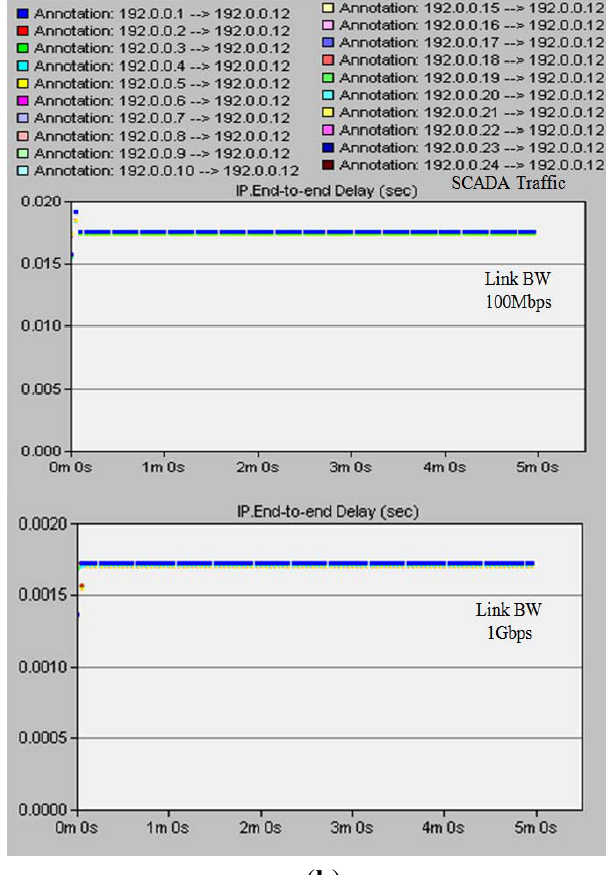
Figure 13. ( a ) ETE delay of SCADA traffic for wind turbines in a small-scale